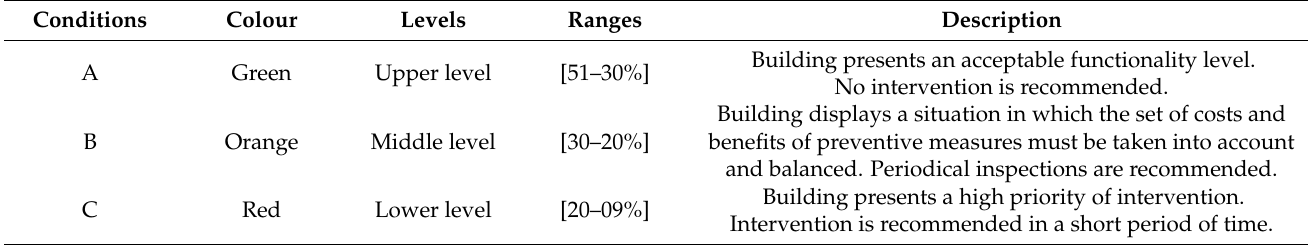
Table 4. Functional degradation conditions regarding the context of South Chile (data sourced from (Prieto, Verichev and Carpio,